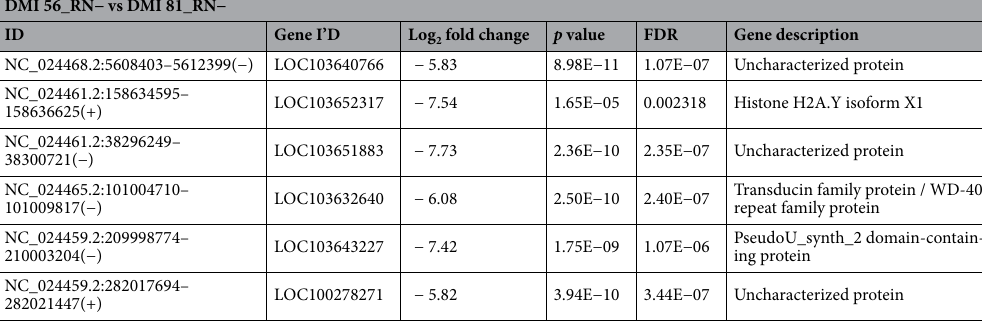
(Fig. 7). Further, genes related to amino-acid synthesis and metabolism (for example; Zm00001d048050, Zm00001d028750) were down-regulated, while genes related to the release of amino acids were up-regulated (for example; Zm00001d009944, Zm00001d031486, Zm00001d016476, and Zm00001d012667) which suggests that during the early stages of N-deficiency, recycling might be the main source of fulfilling the initial demand of N for growth and development of plant 41 .